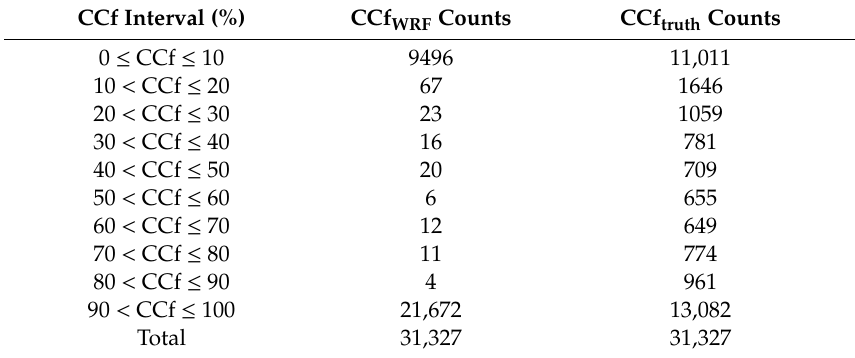
Figure 5. Comparisons between CCf truth and CCf WRFrst results valid at 1800 UTC on 18 Nov 2104. ( a ) Mean CCf truth for all clouds in the VIIRS data 2014 after mapping the MGCNC image to the WRF grid, ( b ) CLDFRAmax of all eta levels for each WRF grid (i.e., CCf WRF for all clouds) in the 6 h baseline WRF simulation from NAM data at 1200 UTC and ( c ) CLDFRAmax image after the bogus process has been applied using CCf truth data. Legends are same as those used in Figure 3. Table 3. Frequency of cloud cover fraction (CCf) for all clouds contained in the mean CCf truth data and the maximum value found at all eta levels for each collocate grid in the WRFrst